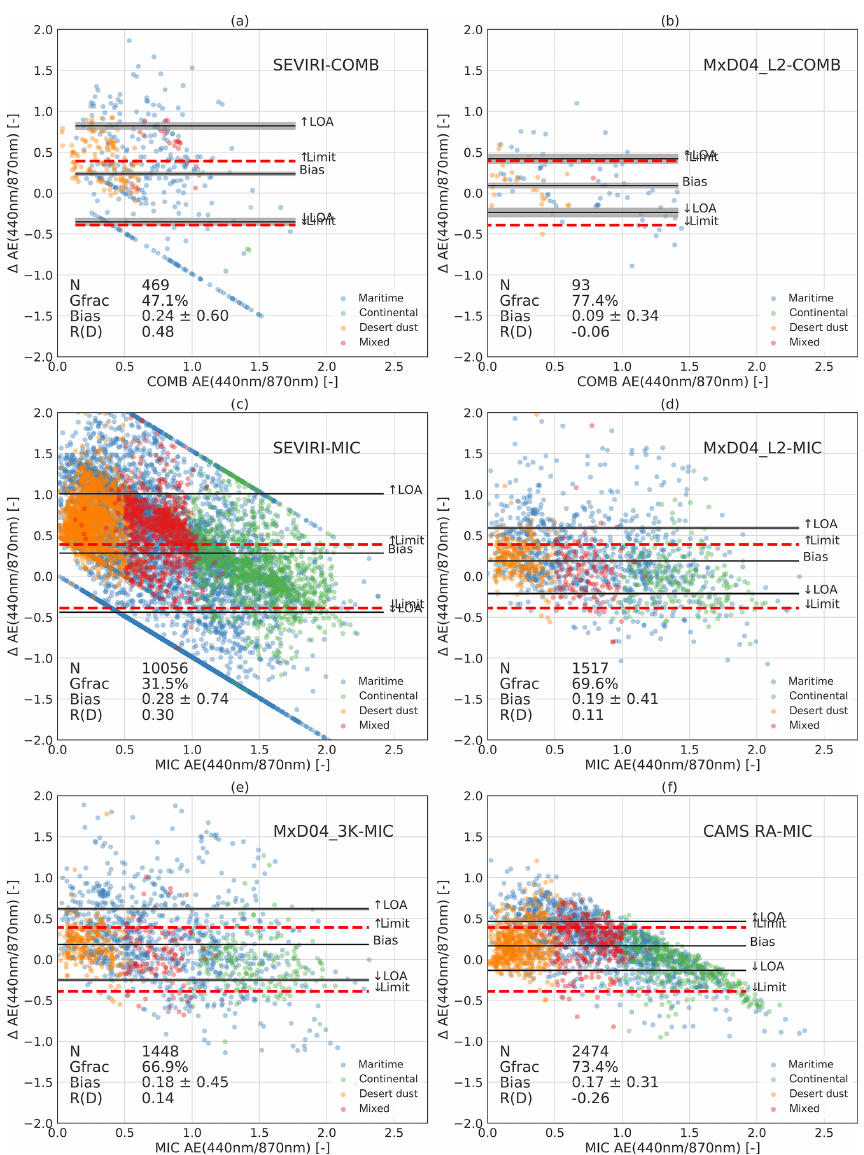
Figure 6. Comparison of AE from the COMB or MIC reference datasets versus the SEVIRI, MxD04 , and CAMS RA datasets. The aerosol type classified with the reference dataset is indicated by the colour of each point. Dashed red lines indicate the estimated error limits for AE ( ± 0 . 4) of the MODIS products (Chu, 2002). Overall, 67% of AE data points are expected to fall into these limits. LOAs (outer black lines) are based on 67% confidence intervals. The bias is given by the middle black line and is calculated as the mean of the difference. The statistics state the number of measurements ( N ), percentage of data within expected error limits (Gfrac), bias ± LOA, and correlation of the difference ( R(D)